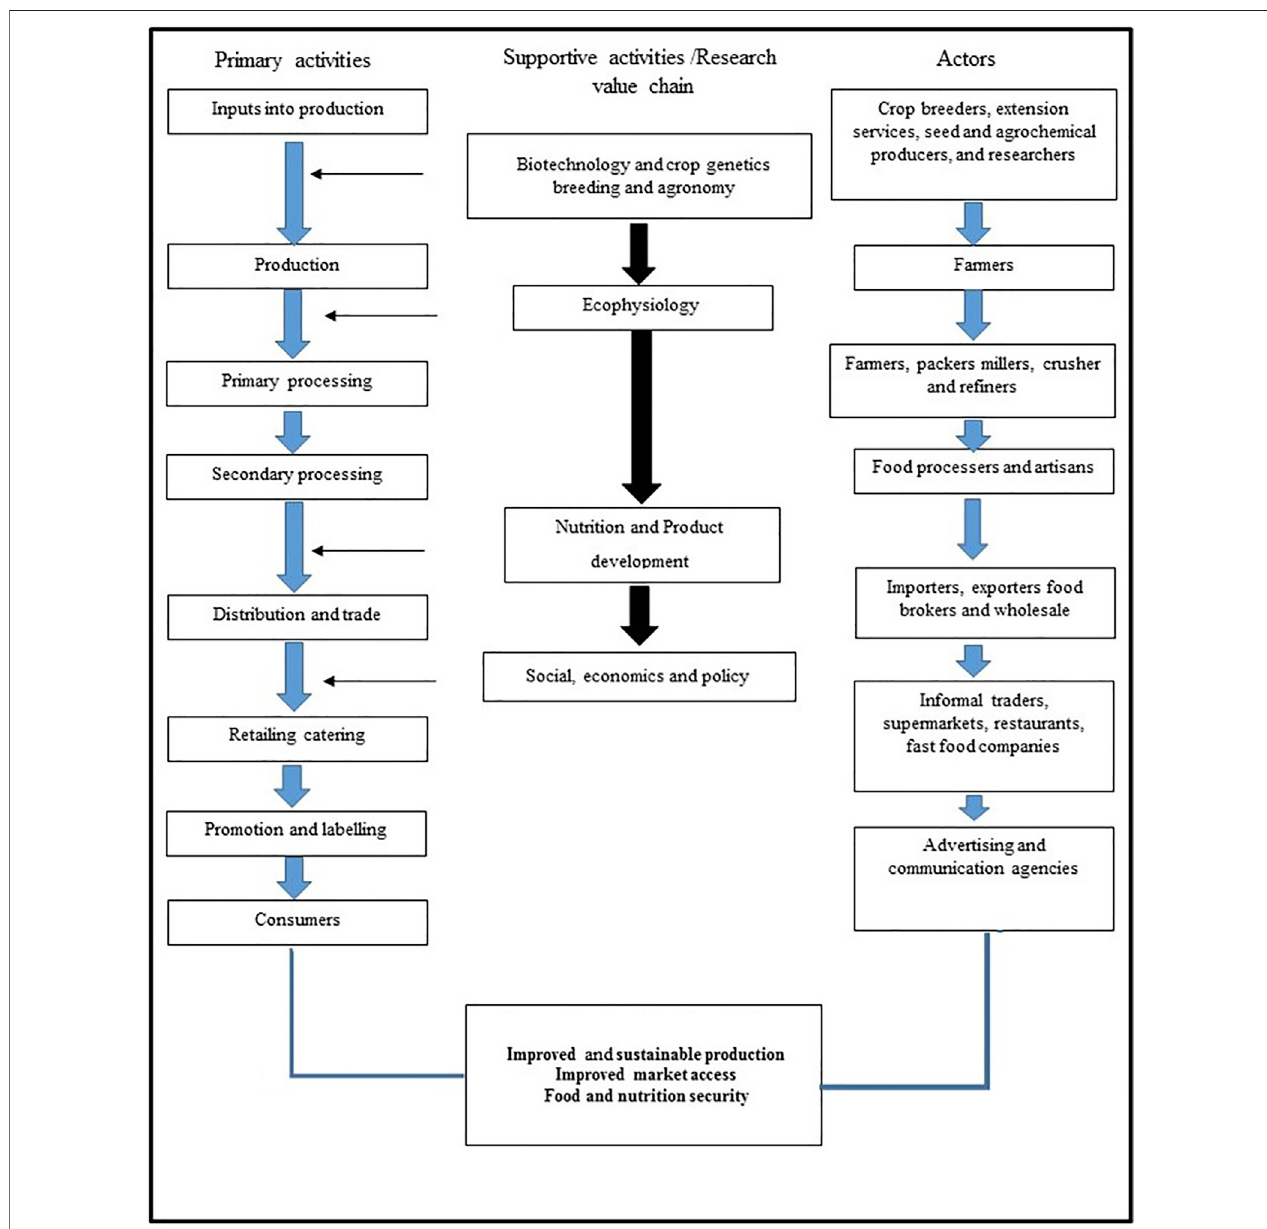
FIGURE 5 | Value chain of neglected and underutilised crops indicating primary and support activities and actors involved during the primary activities (Source: Mabhaudhi et al., 2017).